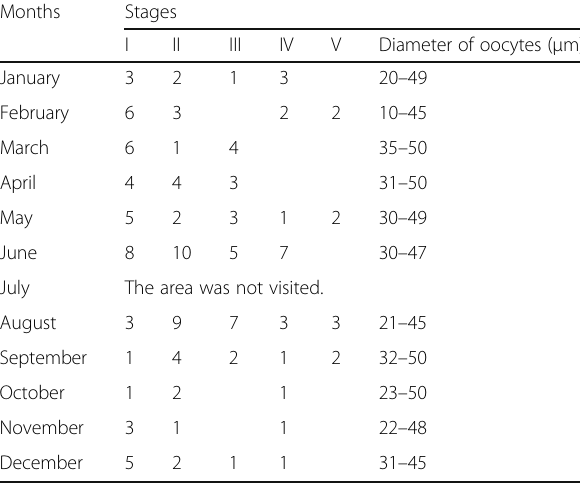
Table 3 Maturity stages of H. marsupialis ovigerous females from Gulf of Aqaba, Red Sea,